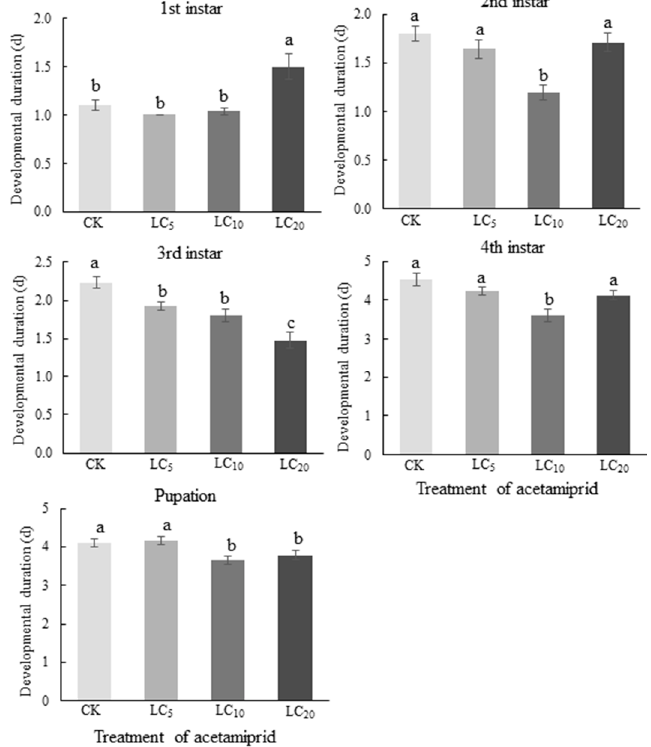
Figure 1. Effects of acetamiprid on C. septempunctata developmental duration within the 1st instar larval stage (mean ± SE). The same column followed by different letters is significantly different based on ANOVA using Tukey’s LSD test ( p < 0.05).